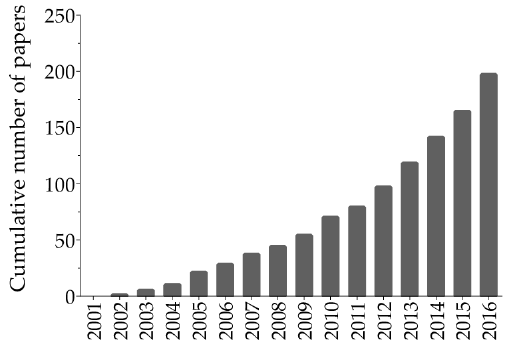
Figure 2. The popularity of health benefits of ellagitannins over time as shown by the cumulative number of papers from 2001 to 2016 obtained by a basic search on the PubMed database using “ellagitannins” and “health” as terms search.